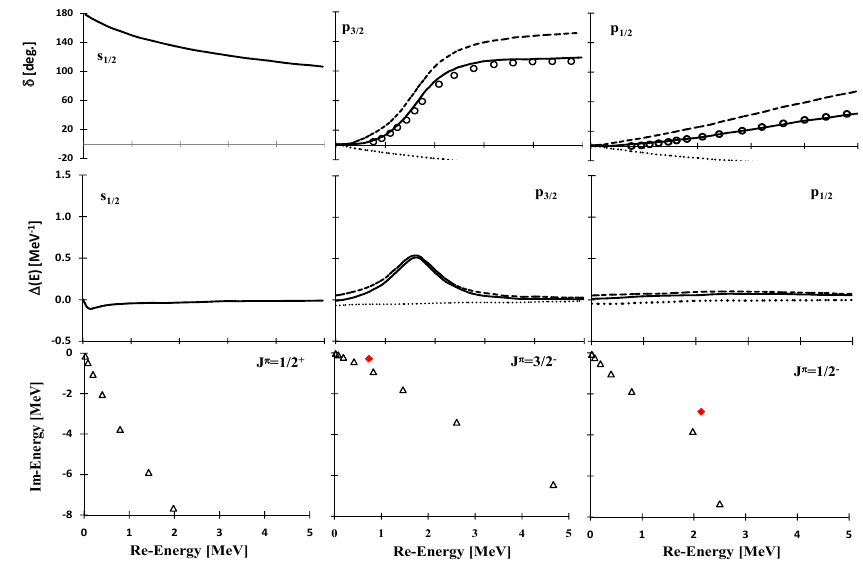
p ( 5 Li) system. The experimental data [8] are shown with open Figure 2. Same as Fig. 1 but for α −